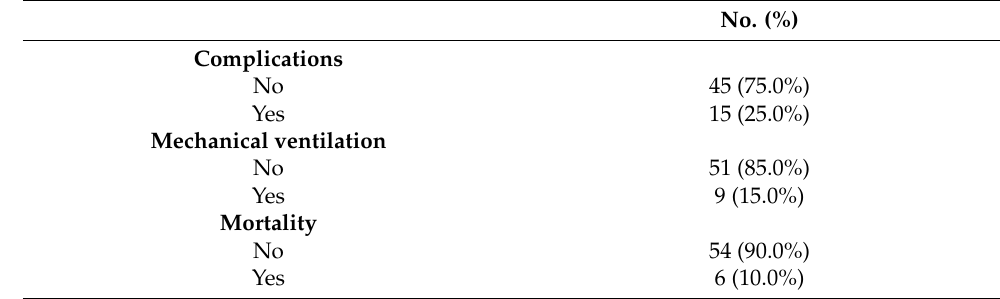
Table 3. Distribution of the studied cases according to complications, mechanical ventilation, and mortality in group III ( n =